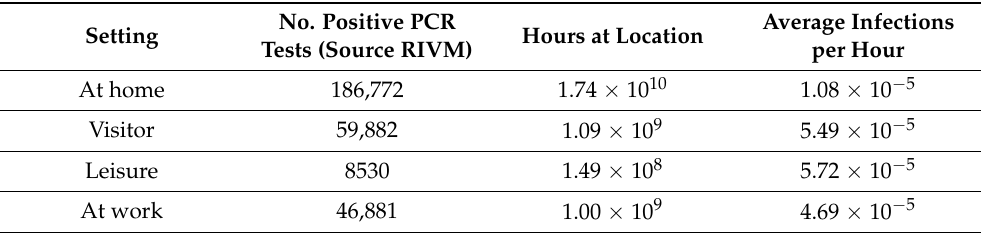
Table 1. Location and infection data used for the least-squares regression of A 1 and A 2 based on RIVM and the survey.